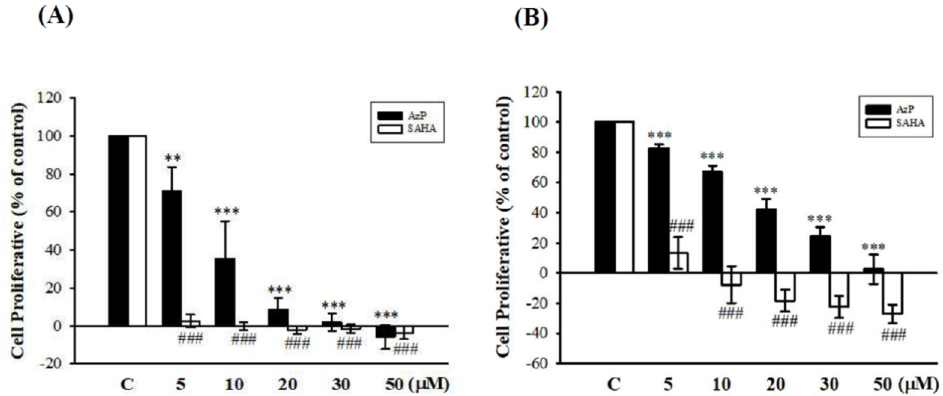
Figure 4. Effects of AzP and SAHA on A549 and Met-5A cell proliferation. A549 ( A ) and Met-5A ( B ) cells (2 × 10 4 ) were dispensed on 96-well plates, SRB assay was performed treated with the indicated concentrations of AzP (5, 10, 20, 30, and 50 µ M) and SAHA (5, 10, 20, 30, and 50 µ M) for 48 h. Cell Proliferation % = {(T48 − T0)/T0} × 100. T48: the signal measured after 48-h treatment, T0: the signal measured before treatment at time 0. Data are expressed as means ± SD from 4 independent experiments, while a minus value indicates cell death. ### p < 0.001 as compared with the SAHA control, ** p < 0.01 as compared with the AzP control and *** p < 0.001 as compared with the AzP control.